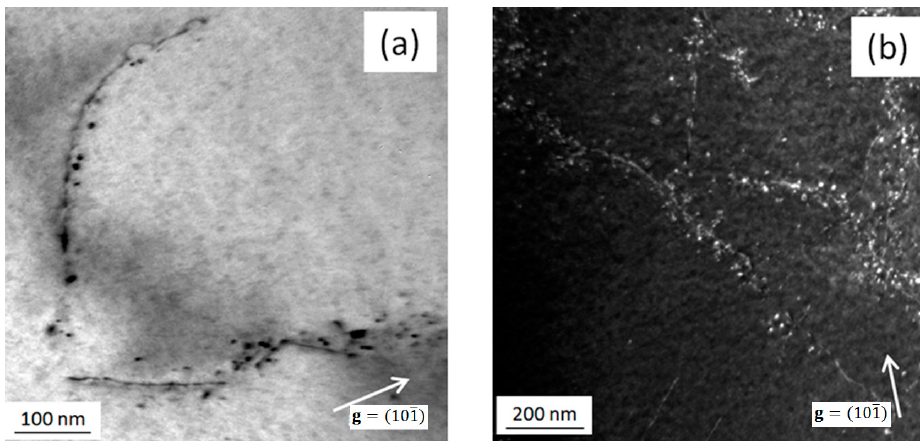
Figure 4. ( a ) TEM bright field image of the 0.6 dpa Fe-9Cr alloy and ( b ) weak-beam dark-field image of the 0.6 dpa Fe-5Cr alloy.